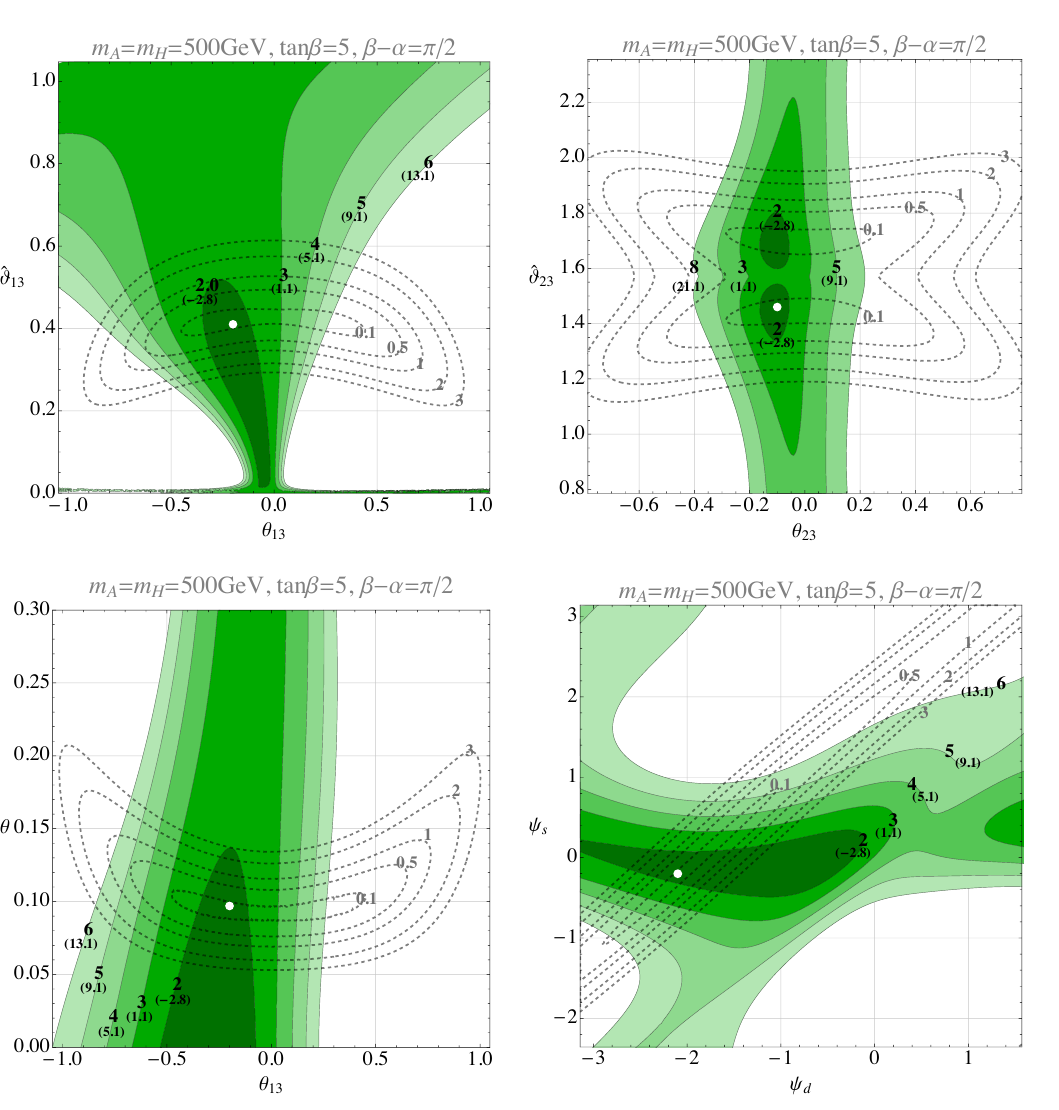
Figure 2 . X 2 = dof regions on various two-dimensional slices of the 1 + 2 (cid:13)avor-locked theory loop parameter space in the neighborhood of the benchmark point (4.4). Contour values are labeled in (cid:0) X 2 black; we also show the values for X 2 (SM) in parentheses. The benchmark point (4.4) loop loop is shown by the white circle. The contours from (cid:12)gure 1 are shown by the dotted lines with the corresponding contours labeled in